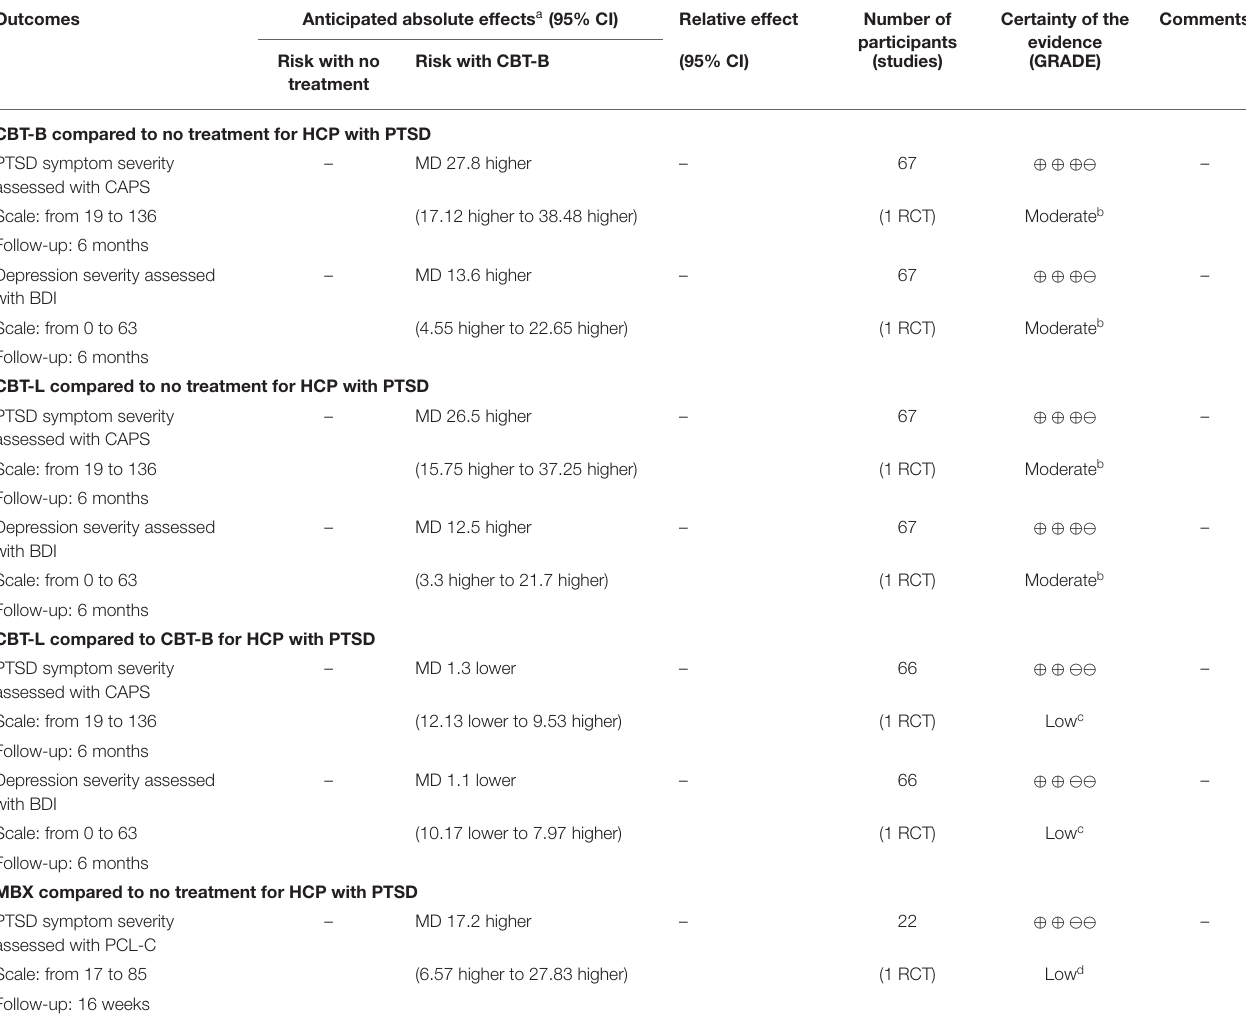
TABLE 2 | Summary of